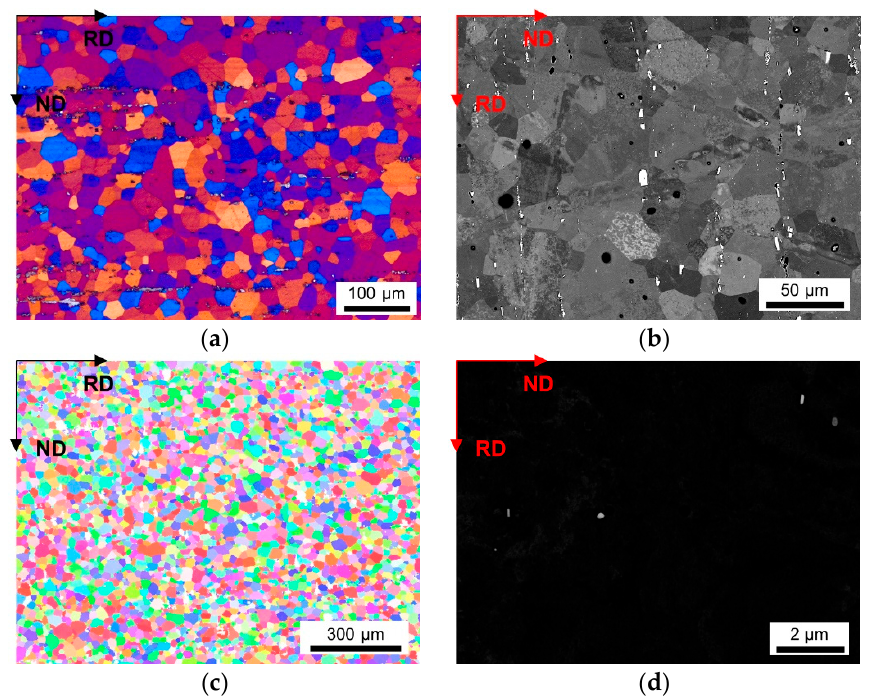
Figure A21. Microstructure of the soft annealed HFe-LMn cast under S-C conditions, homogenized at 550 °C and cold rolled to a CRD of 63%. ( a ) LOM. ( b ) BSE image. ( c ) EBSD IPF map in RD–ND plane. ( d ) BSE micrograph showing dispersoids.